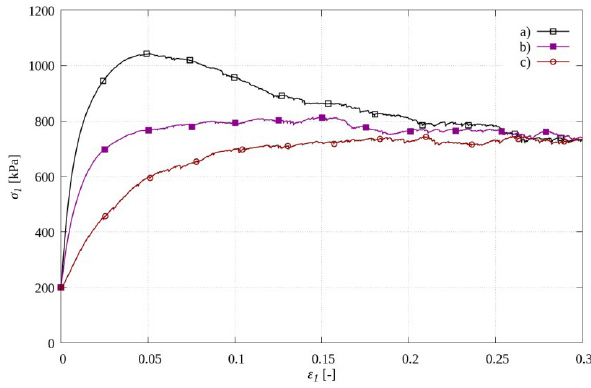
versus vertical normal strain ε 1 1 : a) e = 0.53, b) e = 0.60 and c) e = 0 0 0 0